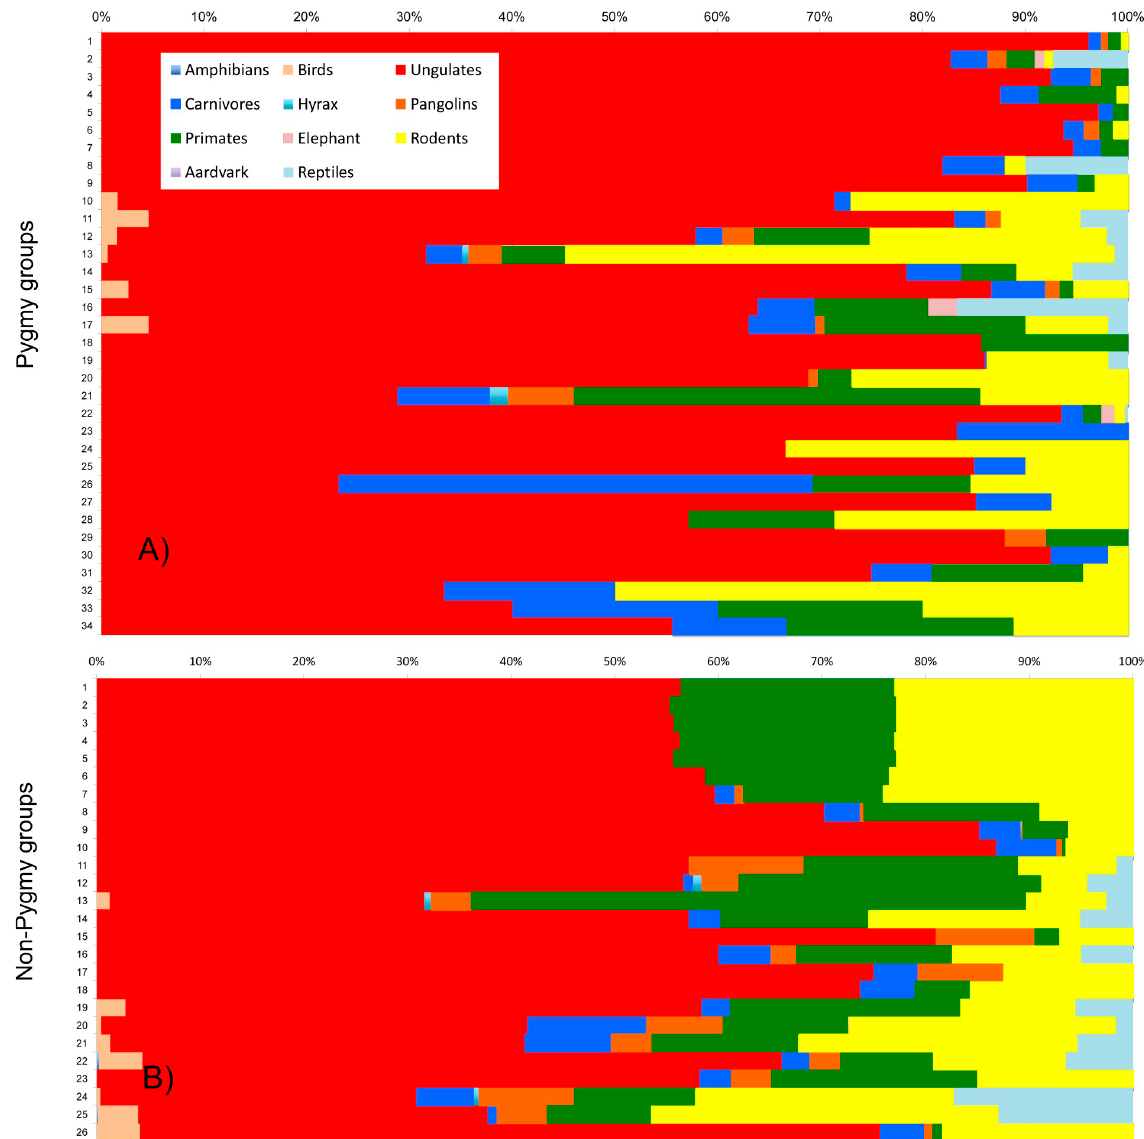
Fig 2. Stacked bar graphs, with sites sorted according to the numbering in Fig 1, of the percentage contribution made by the different taxonomic animal groups hunted by Pygmies and non-Pygmies. in mean body mass was larger in Pygmy sites (range = 2.7–68.6 kg) than in non-Pygmy sites (range = 3. 9–14.2 kg). For both hunter groups (Fig 4), mean body mass was negatively corre- lated with human population density ( R = -0.26, p = 0.05). However, the trend was steeper for Pygmy sites ( R = -0.40, p = 0.02) but positive in non-Pygmy sites ( R = 0.41, p = 0.04).